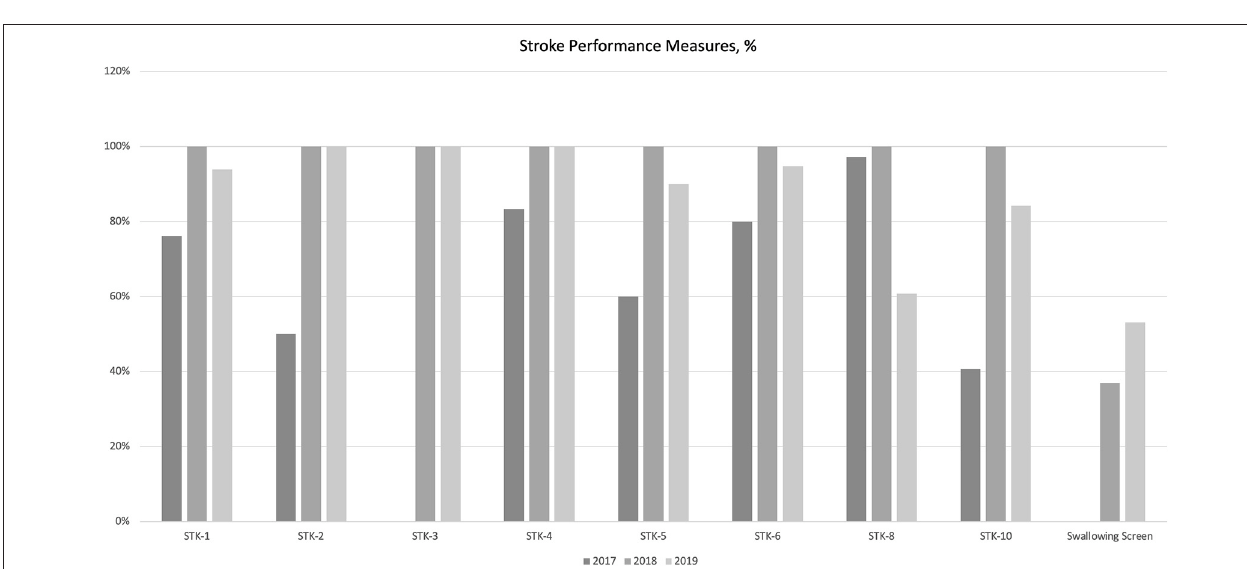
a third of all patients ( Table 2 ). Mean [SD] baseline NIHSS for ischemic stroke patients was 8.5 [7.8] in 2017, 7.4 [5.0] in 2018, and 6.5 [5.1] in 2019 ( p = 0.6725). Most common risk factors for stroke patients include hypertension, type II diabetes mellitus,